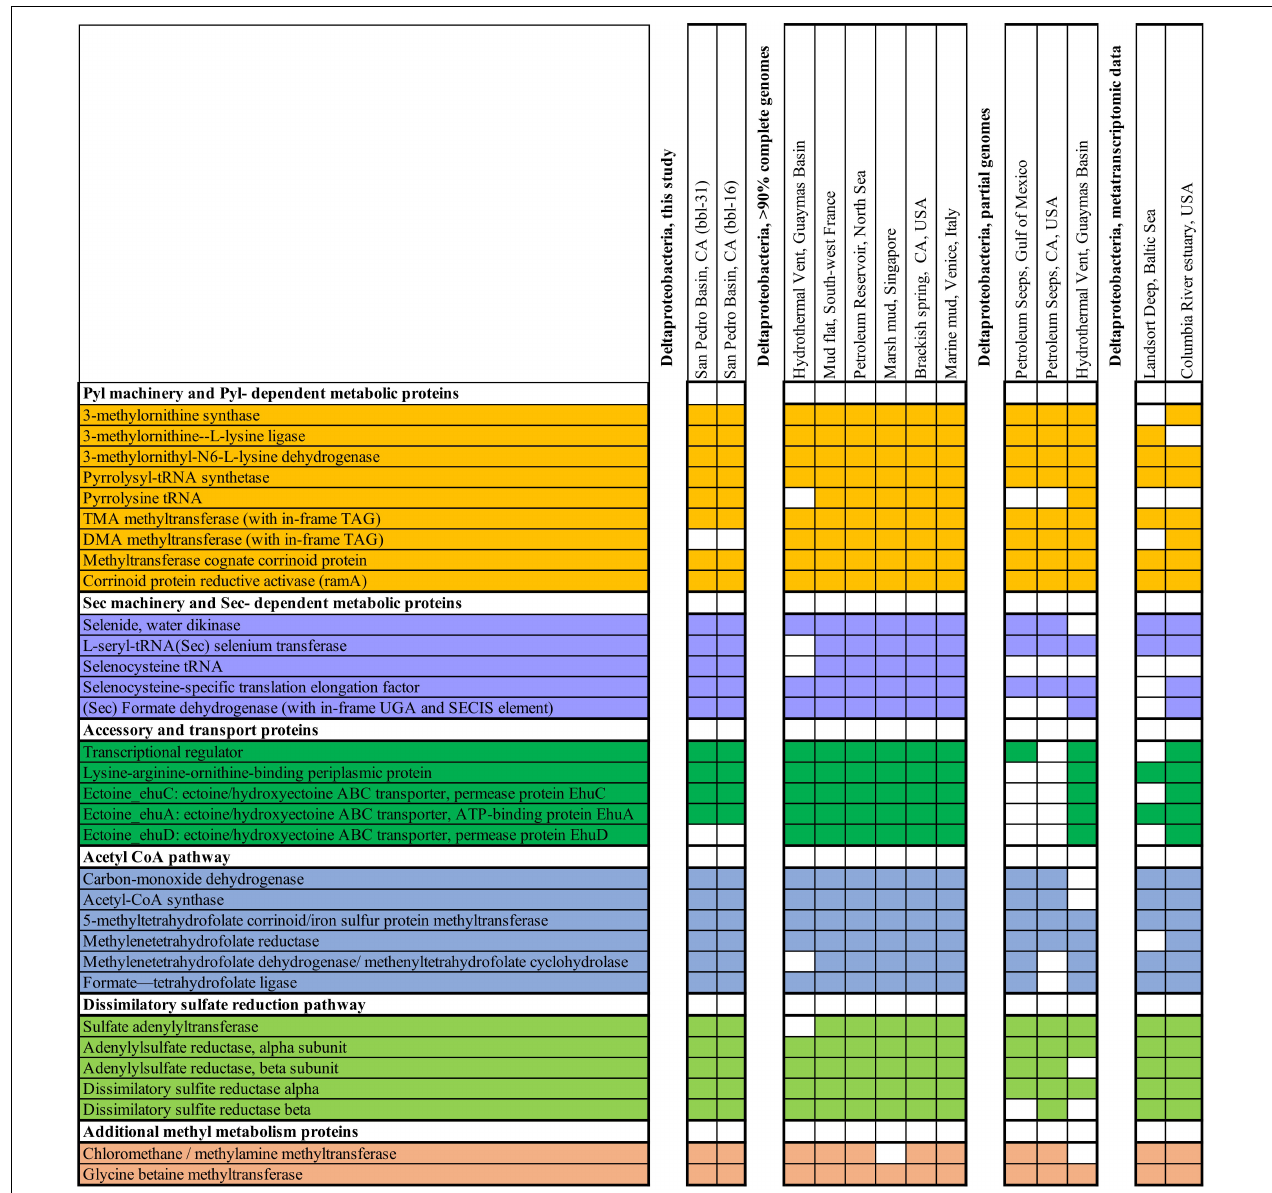
FIGURE 4 | Genes from metabolic, biosynthetic, and other pathways related to genetic code expansion-enabled methyl utilization, shown from Deltaproteobacteria from this study along with other genomic and transcriptomic data sets. Colored boxes indicate that the gene is present in Deltaproteobacteria as either transcriptomic or genomic